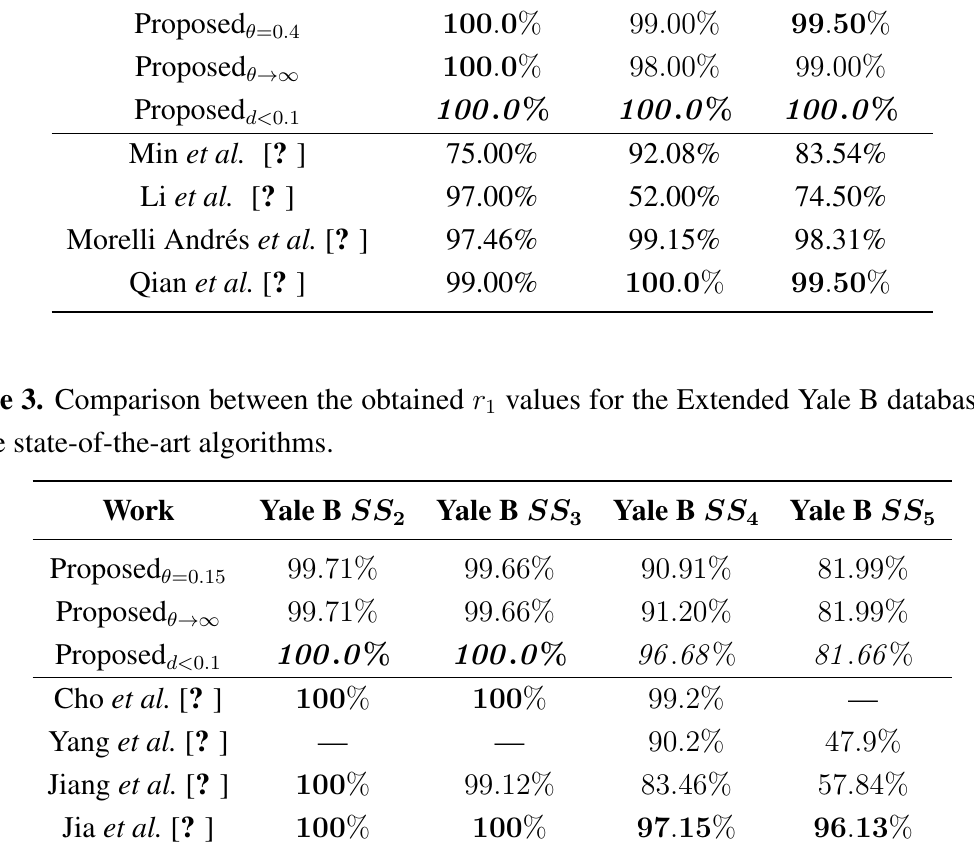
Comparison between the obtained r state-of-the-art algorithms.